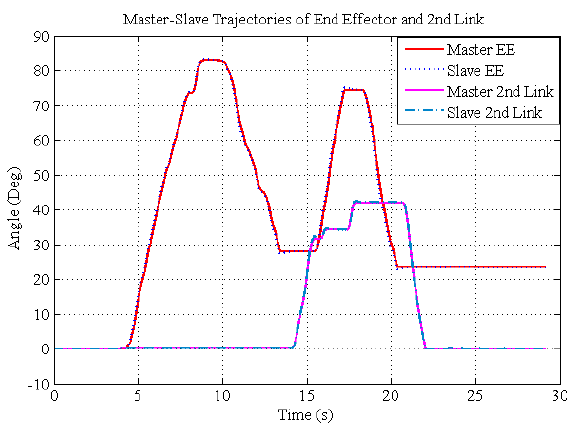
Figure 23. Master / slave trajectories for the end e ff ector and the 2 nd link. Figure 23. Master/slave trajectories for the end effector and the 2 nd link.